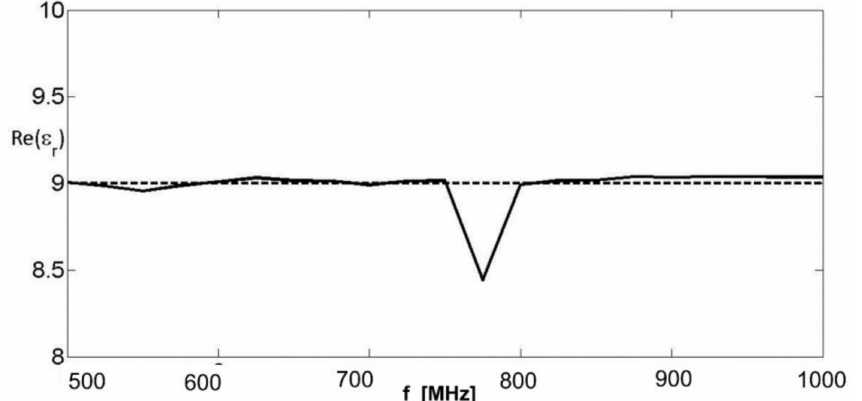
Figure 3. Real part of the equivalent complex permittivity. Solid line: retrieved value; dashed line: actual value.